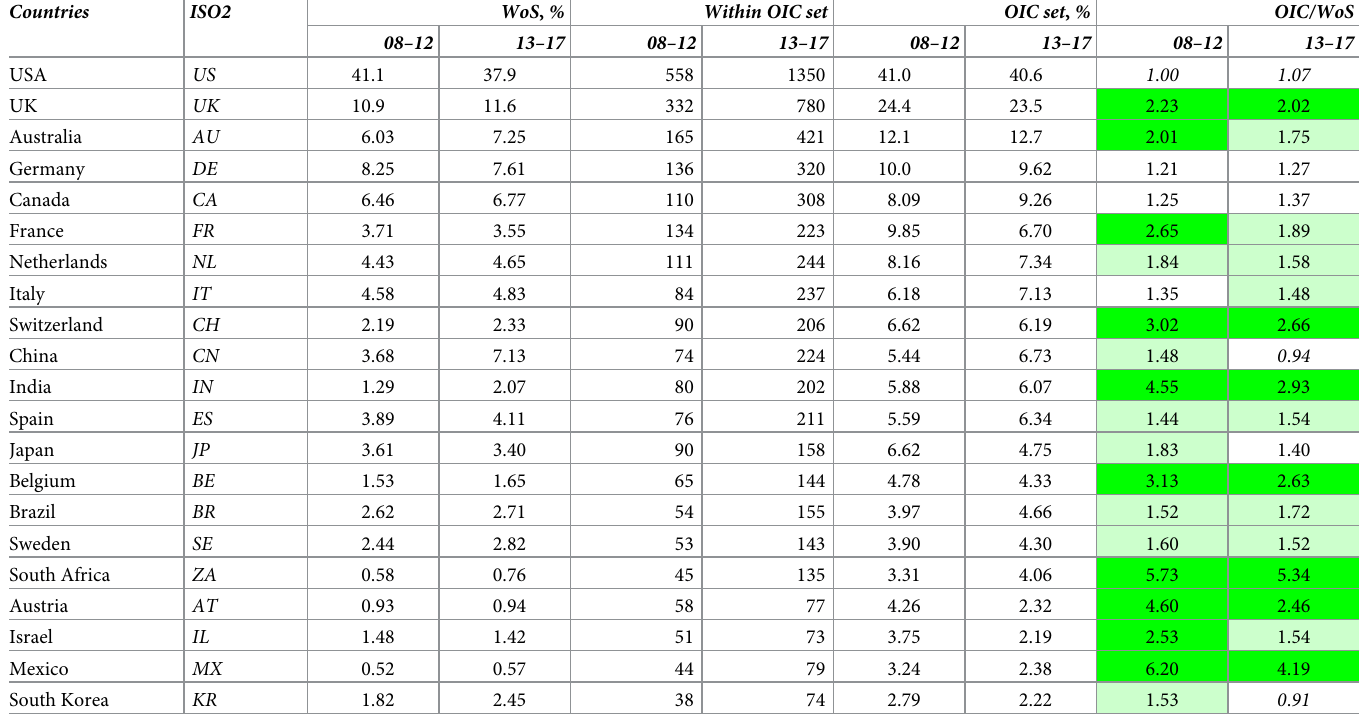
Table 5. Collaboration in mental health disorders research between the OIC countries as a group with individual third countries in two quinquennia, 2008–12 and 2013–17 and percentages of total non-OIC papers (1360 and 3326, respectively; % OIC), compared with the countries’ percentage presence in world mental health disorders research in the same years (WoS, %), and ratio between them, all integer counts.